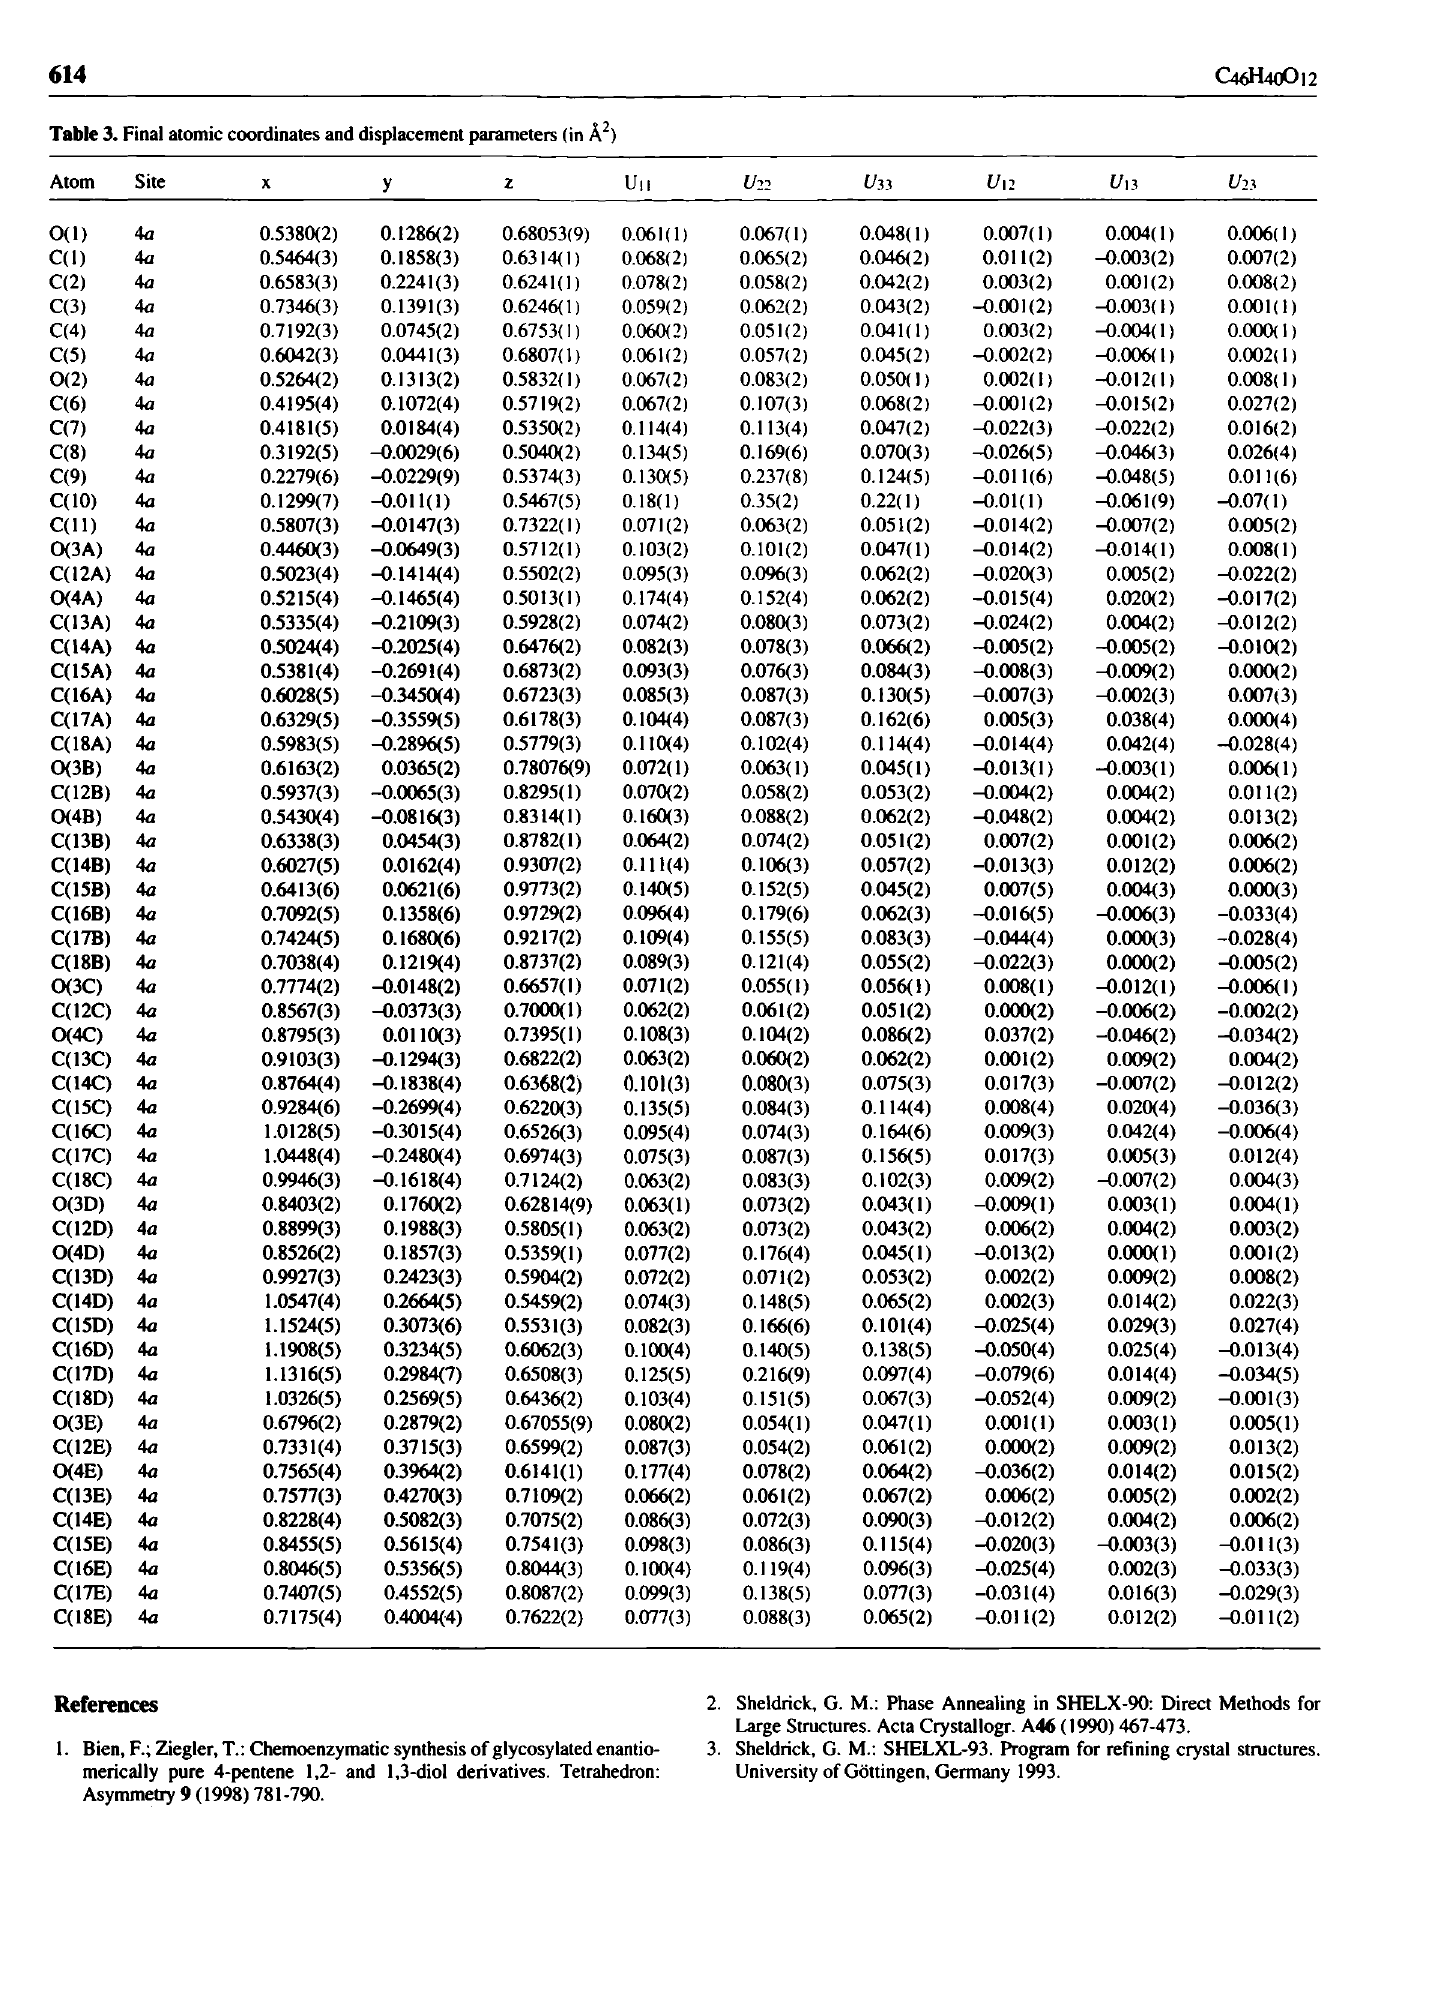
Table 3. Final atomic coordinates and displacement parameters (in A^) Atom